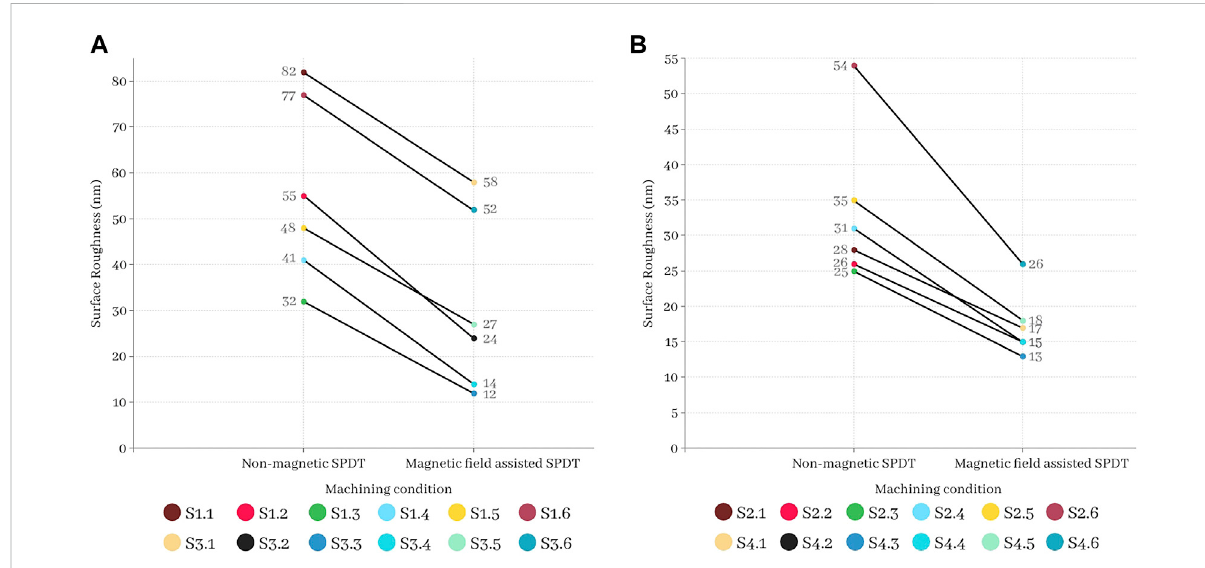
FIGURE 8 The effect of magnetic fi eld assistance on the quality of surface fi nish in all machining series in Table 2: (A) Dry cutting conditions with air coolant; (B) Wet cutting conditions with Kerosene.